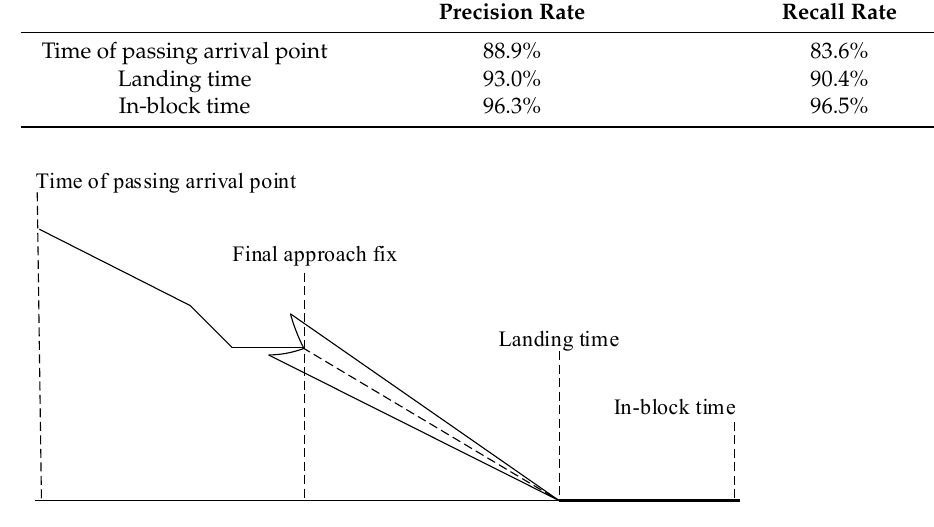
Figure 10. Schematic diagram of the flight approach process.